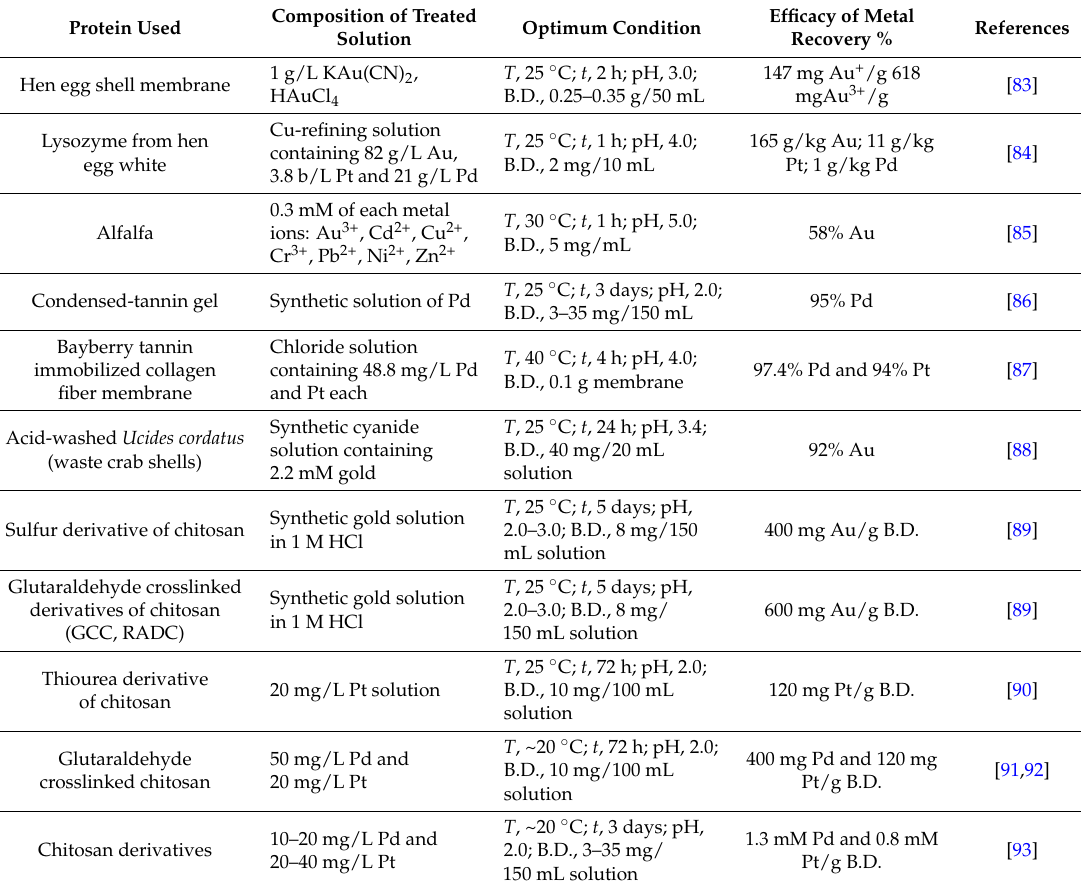
Table 4. A summary of the biosorption studies of precious metals using protein biomass ( T = temperature, t = contact time, B.D. = biosorbent dosage).